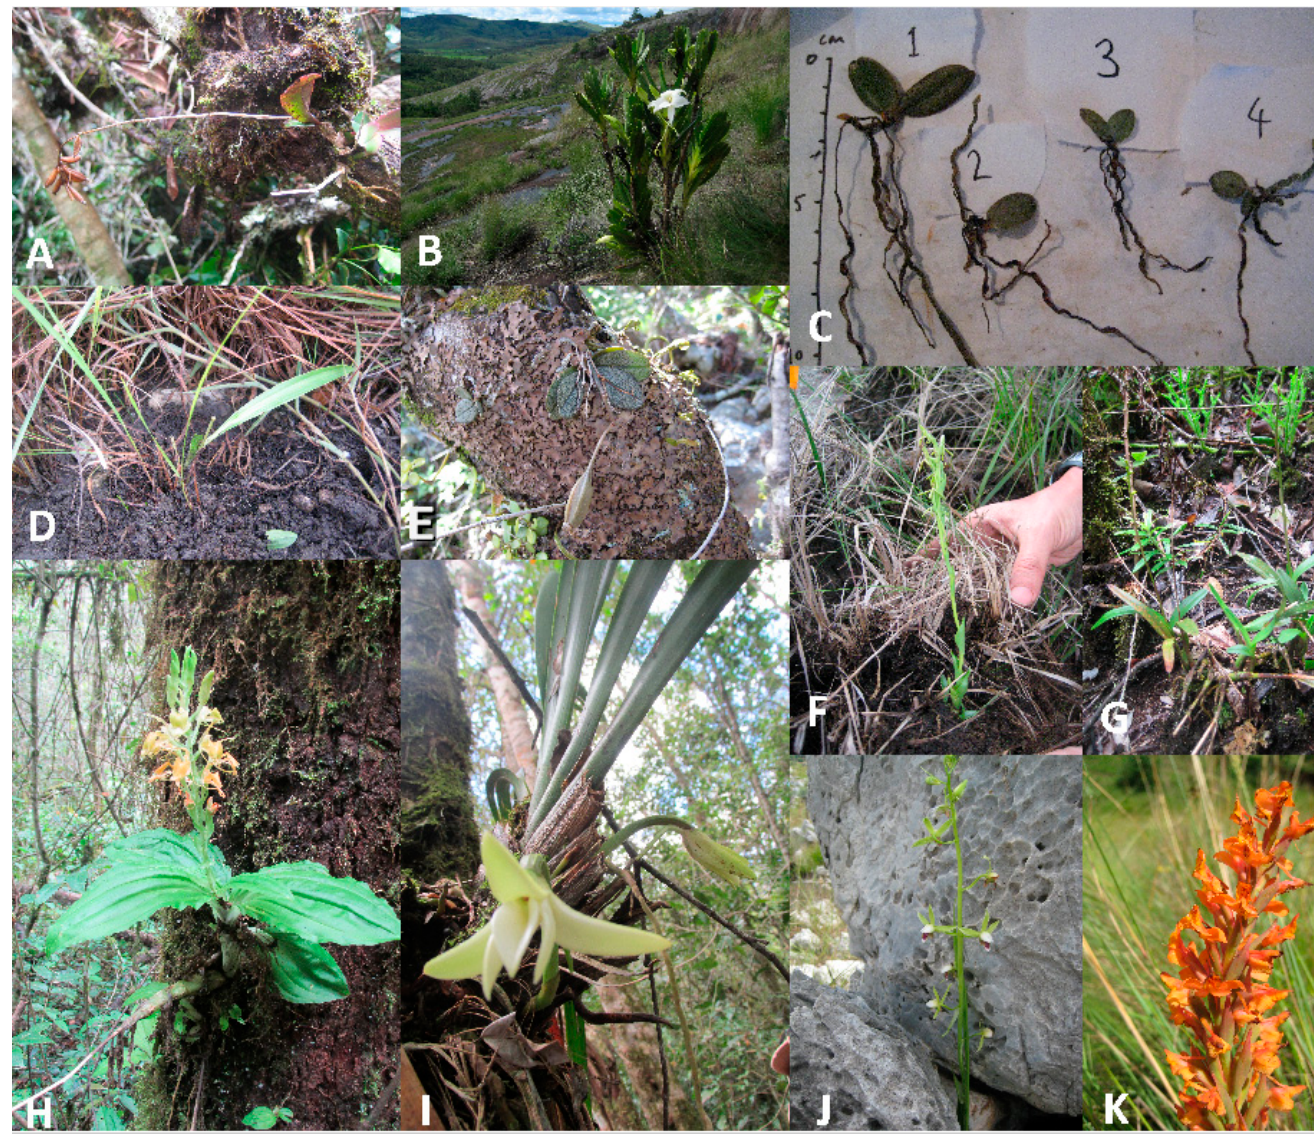
Figure 1. Images of some of the orchids studied. ( A )— Polystachya sp.; ( B )— Angraecum sororium ; ( C )— Aerangis fastuosa (growth phase of plants collected); ( D )— Habenaria sp.; ( E )— Aerangis punctata ; ( F )— Habenaria simplex ; ( G )— Polystachya concreta ; ( H )— Liparis ochracea ; ( I )— Jumellea pachyceras ; ( J )— Eulophia plantaginea ; ( K )— Disa incarnata .